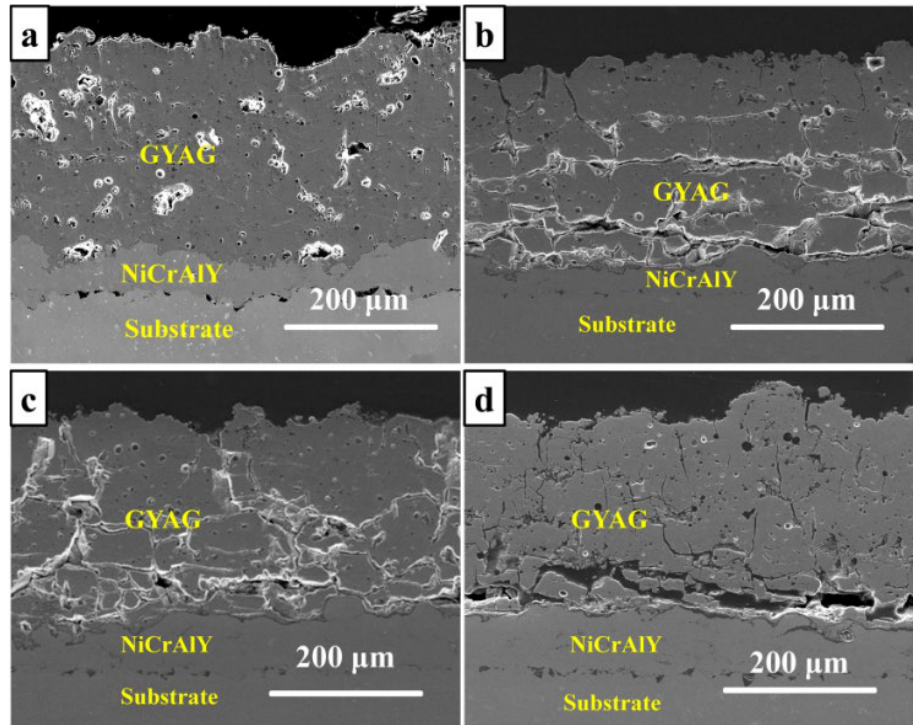
Figure 10. Cross-section SEM images of the GYAG coating at 1100 °C for different times: ( a ) as- deposited; ( b ) 2 h; ( c ) 5 h; ( d ) 10 h.